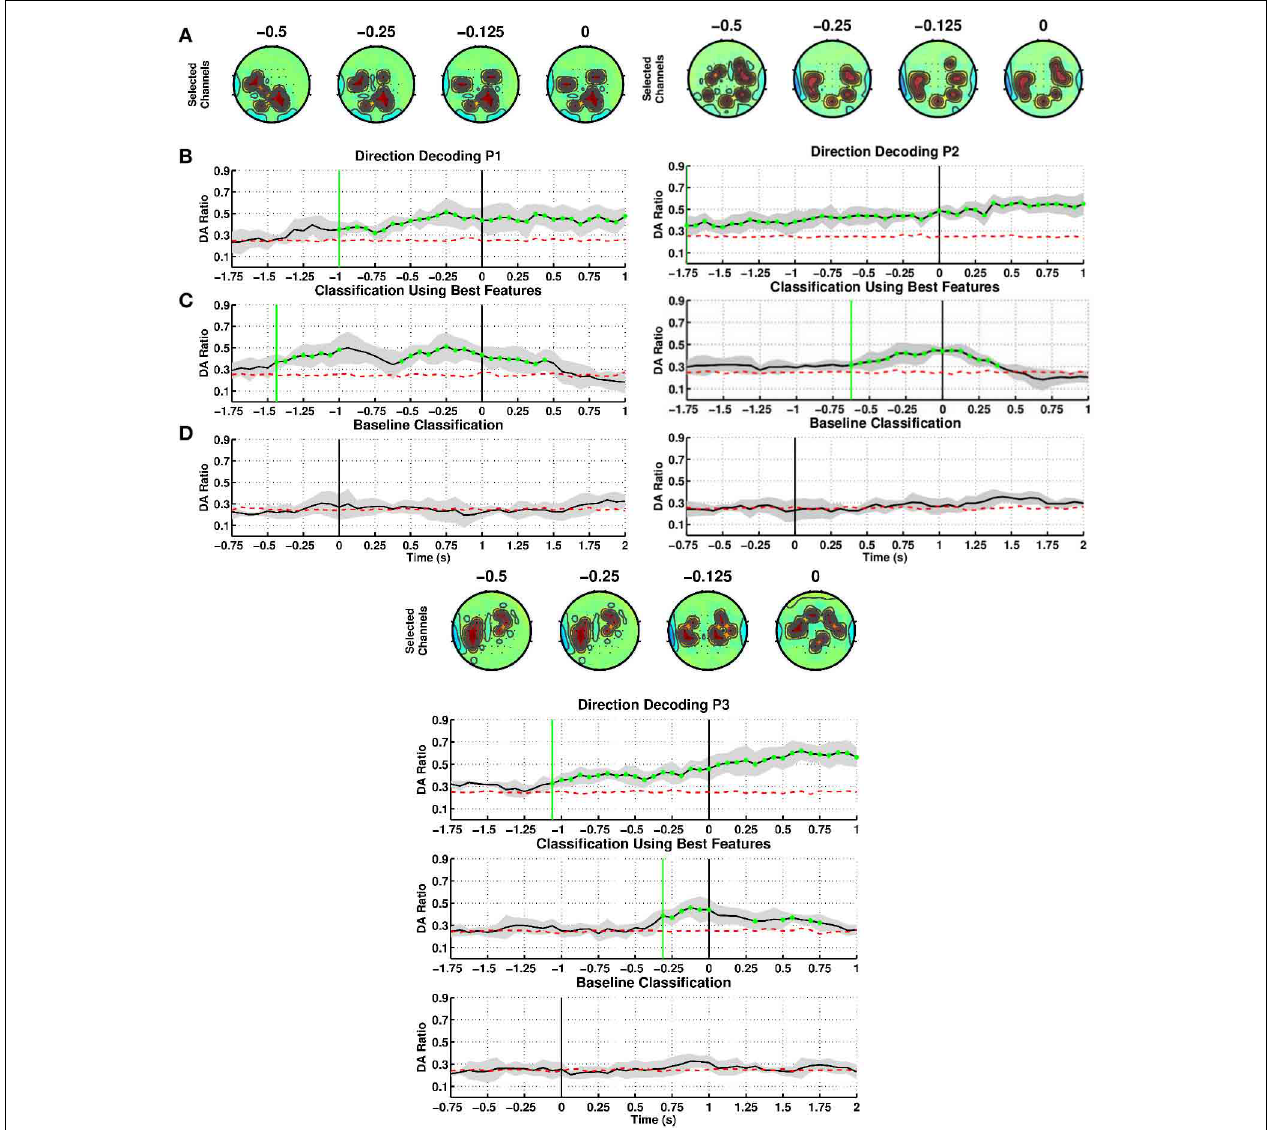
FIGURE 4 | Decoding of movement direction based on SCPs. Stroke patients P1, P2, and P3 performed the reaching with their paretic arm. (A–D) as in Figure 2